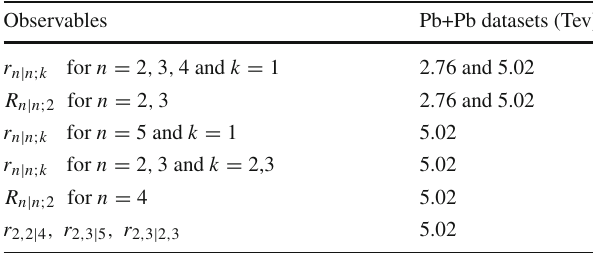
Table 1 The list of observables measured in this analysis Observables